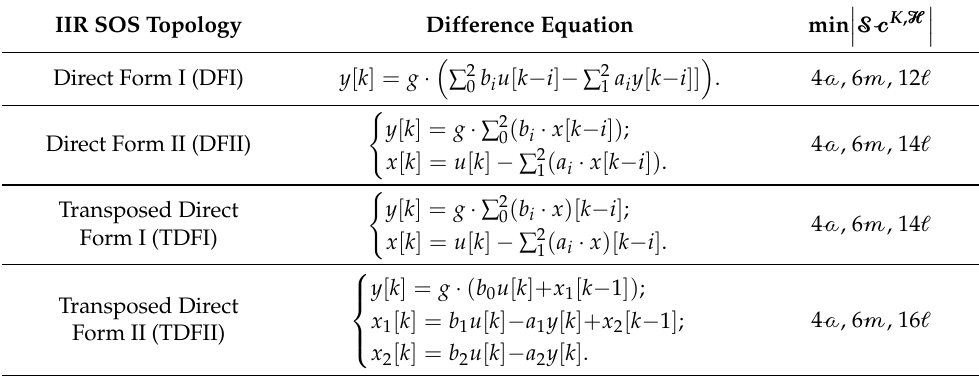
Algorithm 1. hlBased on the specifications for (cid:72) , each line of the pseudocode will have a set of mandatory mathematical operations, along with optional operations, which will be accounted for in the execution time analysis model through different constant